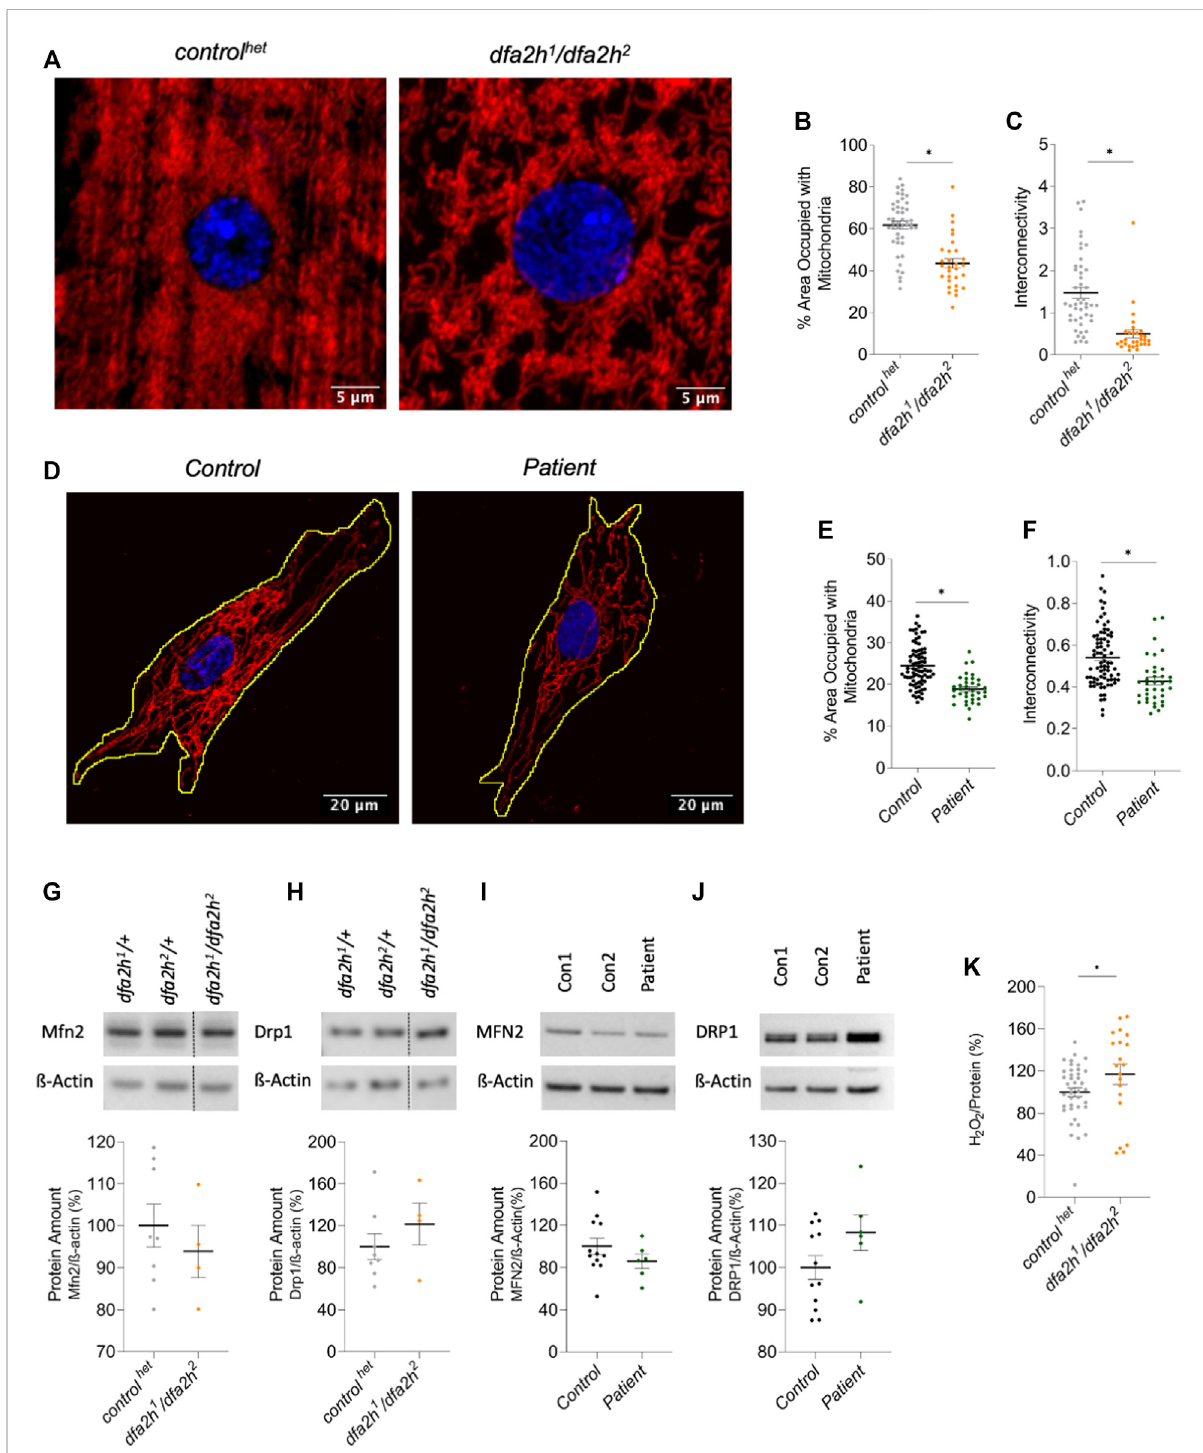
FIGURE 3 Immunolabeling reveals mitochondrial changes upon loss of FA2H. (A – C) Larval muscle sections labeled with mitochondrial marker ATP5a. (A) Confocal microscopy images show mitochondrial alteration in loss of dfa2h larval muscle sections. The red signal shows ATP5a labeling visualizing mitochondria, and the blue fl uorescence DAPI labeling to visualize the nucleus. (B) dfa2h mutant fl ies present with less area covered with mitochondria compared to control het and (C) reduced interconnectivity calculated by area/perimeter ratio. The dots represent single data points, and the lines show mean ± SEM ( n = 25 – 46). (D – F) Immunolabeling patient-derived fi broblasts using